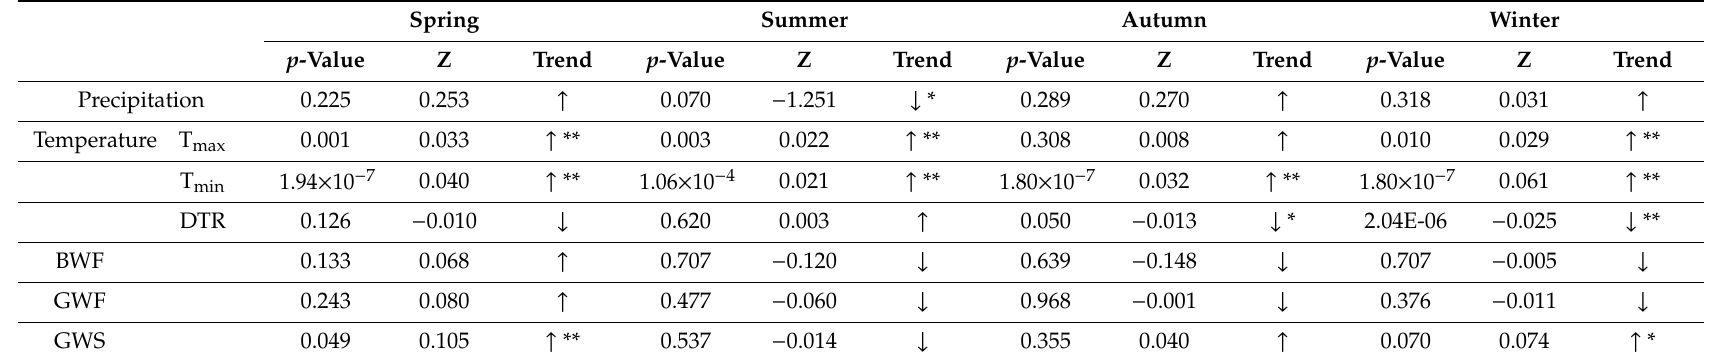
Table 4. The result of MK test for seasonal variation of climate elements and hydrological components in Luanhe River Basin. Spring Summer Autumn Winter p -Value Z Trend p -Value Z Trend p -Value Z Trend p -Value Z Trend